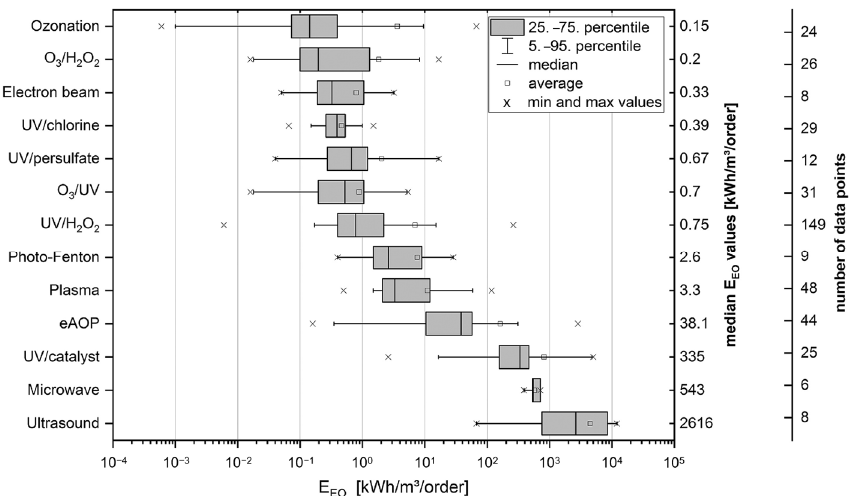
Figure 7. Overview of published EEO values of different AOPs sorted according to median values. For O 3 - and UV-based AOP data, only substances resistant to direct ozonation/photolysis are shown. Median values and number of data points are reported on the second and third y-axis, respectively. Reproduced with permission from [123].